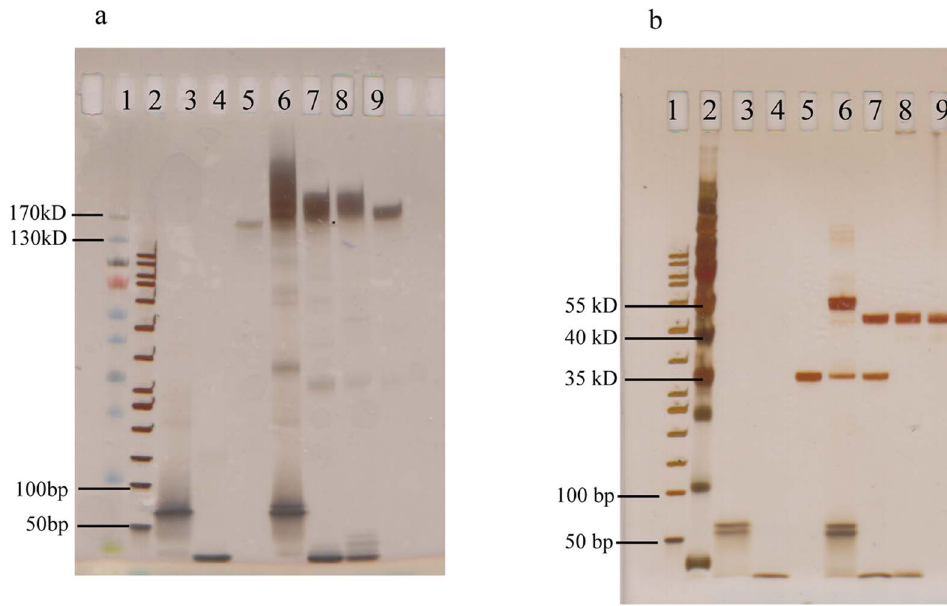
Figure 2. Gel electrophoresis of samples undergoing two-step purification. (a) Polyacrylamide gel of samples from purification of antibody- DNA conjugates and controls. Lane 1: PageRuler protein ladder (10–170 kDa, Thermo Scientific), Lane 2: 50 bp DNA ladder (Thermo Scientific), Lane 3: Arm1_long oligonucleotides (54 bp), Lane 4: Arm1 oligonucleotides (35 bp), Lane 5: anti-IL8 antibodies, Lane 6: conjugation reaction mixture of anti- IL8 and Arm1_long, Lane 7: conjugation reaction mixture of anti-IL8 and Arm1, Lane 8: eluate of captured sample of lane 6 after MlyI cleavage, Lane 9: anti-IL8 conjugates after two-step purification. The gel was stained with PlusOne DNA Silver Staining Kit. (b) Polyacrylamide gel of samples from purification of DARPin-DNA conjugates and controls. Lane 1: PageRuler protein ladder, Lane 2: 50 bp DNA ladder, Lane 3: S3block_long oligonucleotides (51 bp), Lane 4: S3block oligonucleotides (29 bp), Lane 5: G3-SNAP (34.5 kDa), Lane 6: conjugation reaction mixture of G3-SNAP and S3block_long, Lane 7: conjugation reaction mixture of G3-SNAP and S3block, Lane 8: eluate of sample of lane 6 after MlyI cleavage, Lane 9: G3-SNAP conjugates after the two-step purification. Relevant protein and DNA sizes are indicated. The gel was stained with Silver Stain for Mass Spectrometry